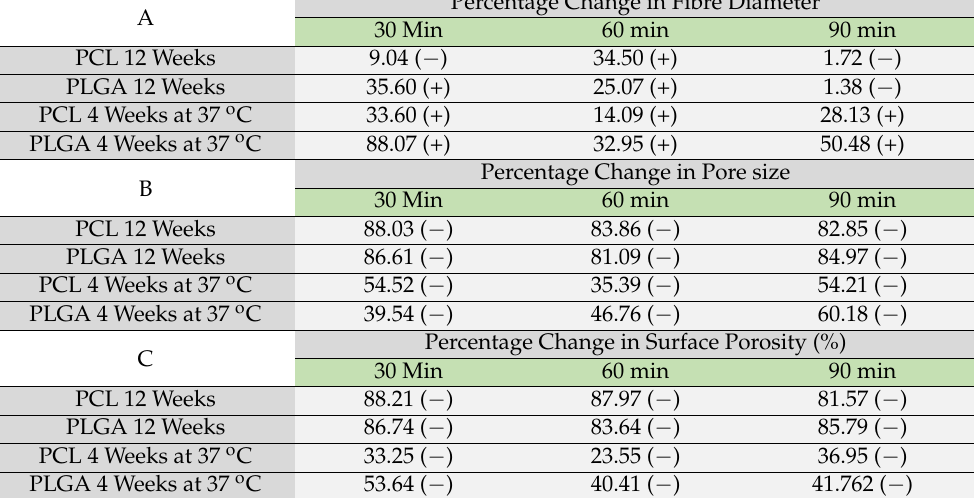
Table 3. (A) Percentage change in fibre dimeter of PCL and PLGA scaffolds at week 12 of degradation compared to week 0, (B) Percentage change in pore size for PCL and PLGA scaffolds electrospun for 30, 60, and 90 minutes, (C) Percentage change in surface porosity percentage for PCL and PLGA scaffolds electrospun for 30, 60, and 90 minutes. ( − ) = decrease and (+) = increase. Percentage Change in Fibre Diameter A 30 Min 60 min 90 min PCL 12 Weeks 9.04 ( −